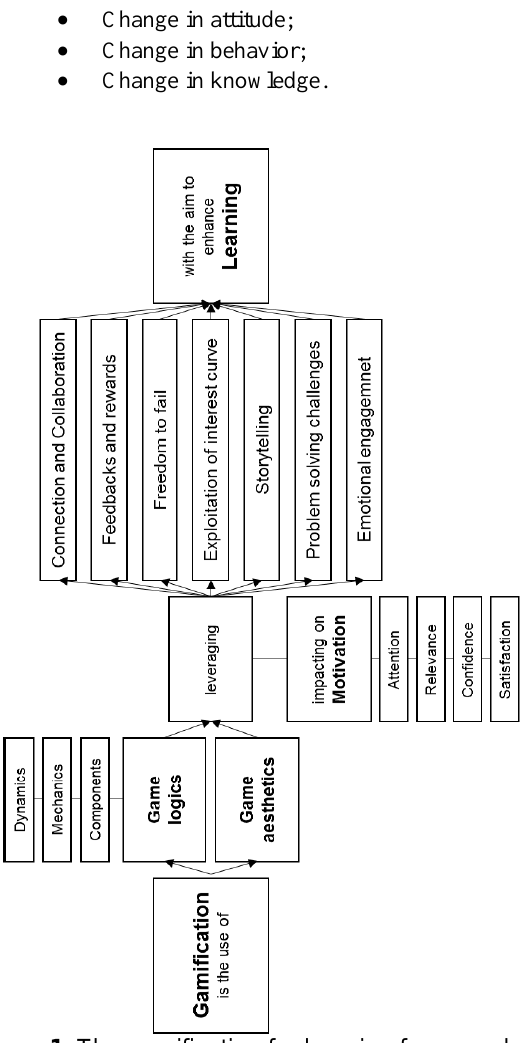
Figure 1. The gamification for learning framework: from the game design to the learning experience